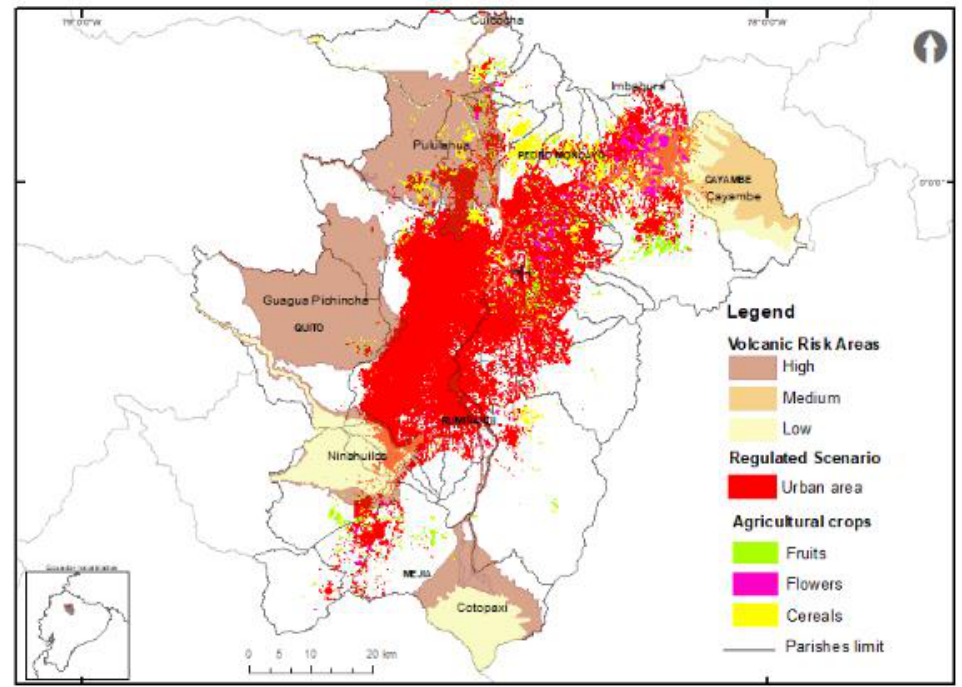
Figure 11. Regulated scenario—volcanic risk areas and agriculture crops, 2050. Source: Geophysical Institute of the National Polytechnic School, 2013.